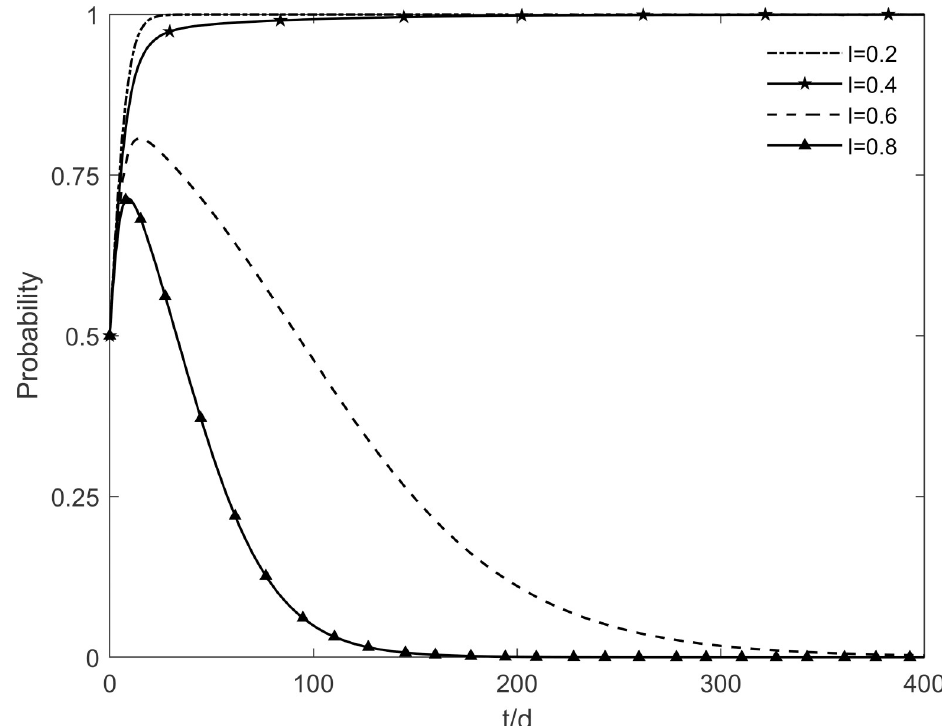
Fig 15. The impact of l on the government’s strategic